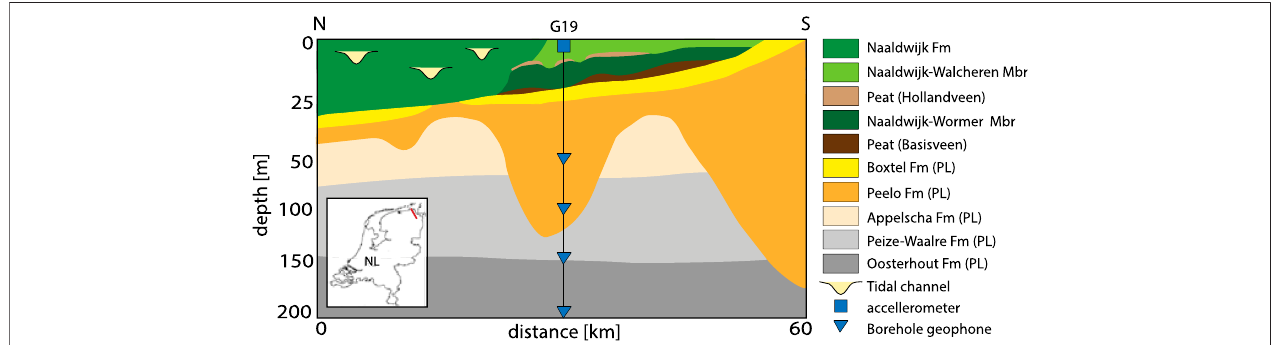
FIGURE 1 | Schematic geological cross section of the upper 200 m of the soft sedimentary cover in the northeastern Groningen region (red line in inset). Note that the vertical scale is in fl ated for the top 50 m to highlight the stratigraphy of the Holocene formations on top of the Pleistocene (PL) formations. Borehole station G19 is featured because this site is used for wave-propagation modeling. The G-network vertical arrays consists 5 seismometers (accellerometer (blue square) at the surface and geophones (blue triangles) at depth) with a 50 m depth interval. This cross section is based on GeoTOP (www.dinoloket.nl).